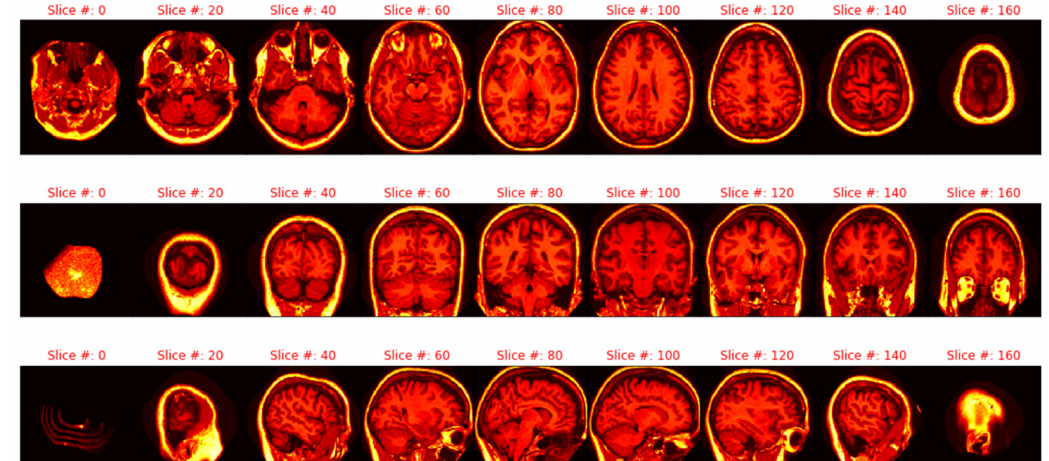
Figure 1. Axial, sagittal, and coronal slices